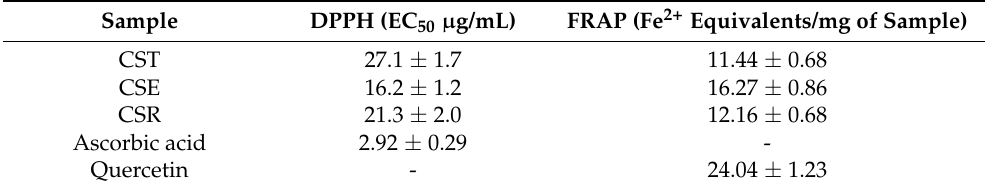
Table 1. In vitro antioxidant determination of the extract and different fractions of C. speciosum leaves using (DPPH • ) and